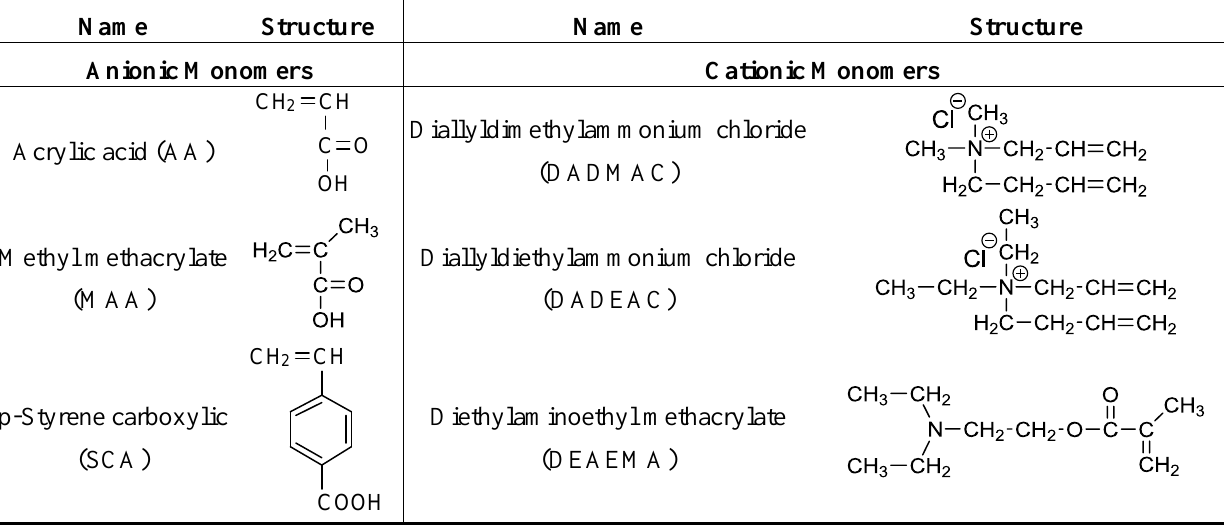
Table 2. Representative anionic and cationic monomers incorporated in